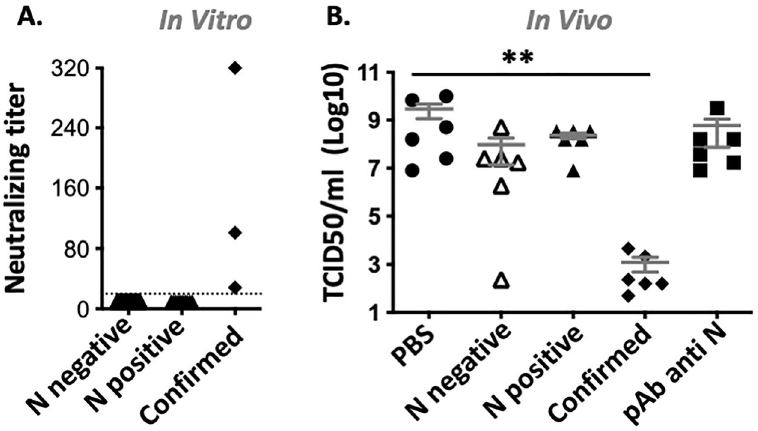
Figure 2. In vitro and in vivo neutralization of human sera with antibodies against SARS-CoV-2 N protein. ( A ) Neutralising titer of sera from Gabonese donors with (N positive) or without (N negative) Ab against SARS- CoV-2 N protein (n = 10/group). Standard sera from COVID-19 confirmed cases with high, medium and low neutralization capacity were used as positive control. Sera with neutralizing titer below the lowest tested dilution (dotted line), are plotted at 10. ( B ) Day 5 lung viral titer (TCID50/ml) in SARS-CoV-2 challenged mice (n = 6/ group) pretreated with either PBS; 1 mg purified IgG from Gabonese sera with (N positive) or without (N negative) Ab against SARS-CoV-2 N protein; or from COVID-19 confirmed cases (confirmed) or with 50 μg polyclonal antibodies against SARS-CoV-2 N (pAb anti N). Mean ± SEM is